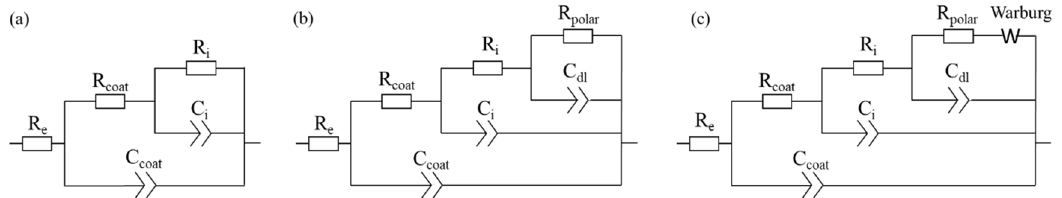
Figure 12. Equivalent circuit models ( a–c ) used for EIS data